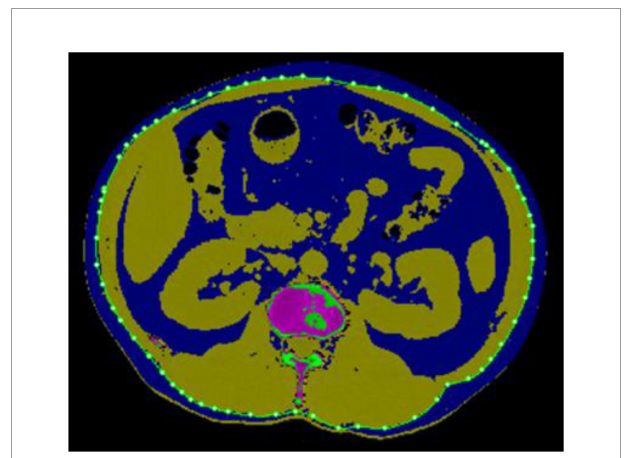
FIGURE 1 | Anatomical location at the hilum of kidney where the maximum correlation of area to volume VAT is achieved for quantitative CT (QCT) method. An attenuation-based semi-automated segmentation using Tissue Composition and the fat was mapped as blue color, then the outer contour of the abdominal wall was used to differentiate visceral adiposity (inner) and subcutaneous visceral adiposity (outer).